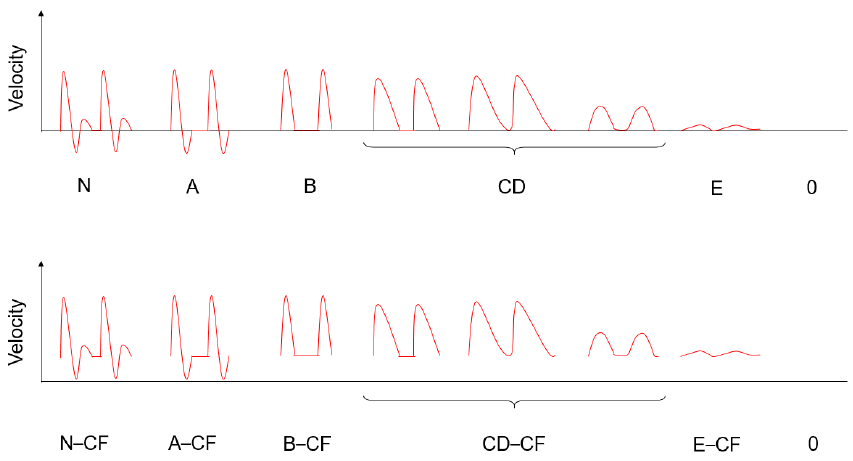
Figure 1. The simplified Saint-Bonnet classification. There was no waveform in categories A–CF and 0 in the present study.